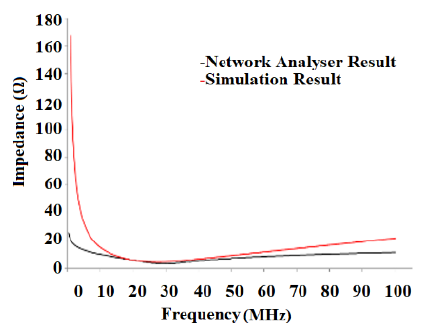
Figure 1. Impedances measurement on unbiased SiC MOSFET using a network analyzer [24]. Reprinted with permission from Ref. [24]. Copyright 2019 Newcastle University.